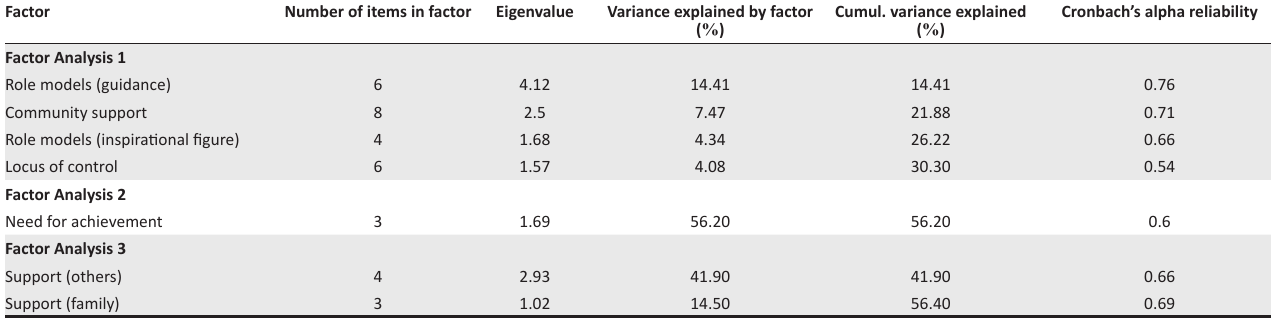
TABLE 1: Summary results of factor analyses. Factor Number of items in factor Eigenvalue Variance explained by factor